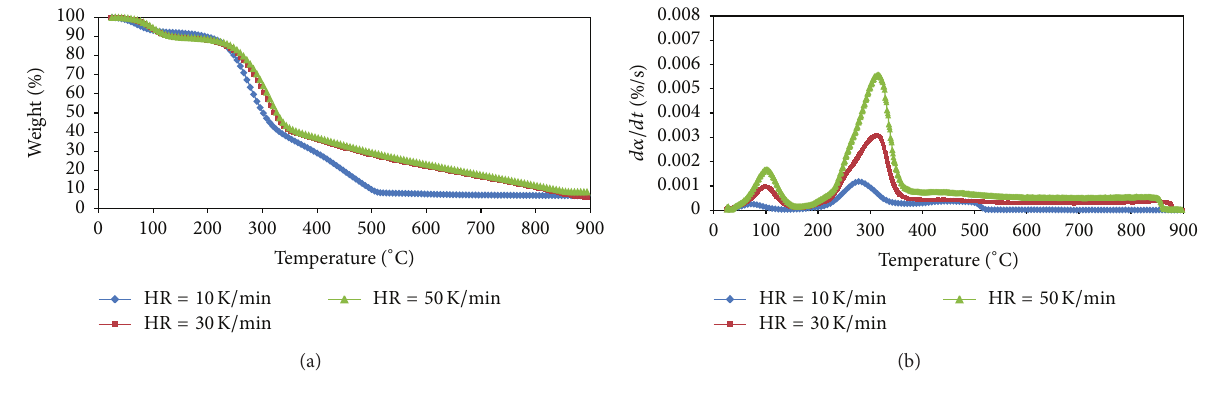
Figure 2: (a) TG and (b) DTG curves of corn